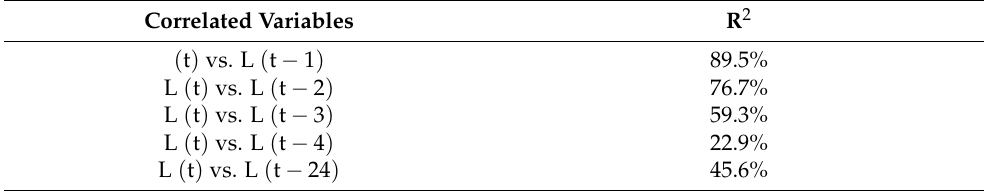
Table 5. R-squared values for the relationship between current and lagged demand at Madaba